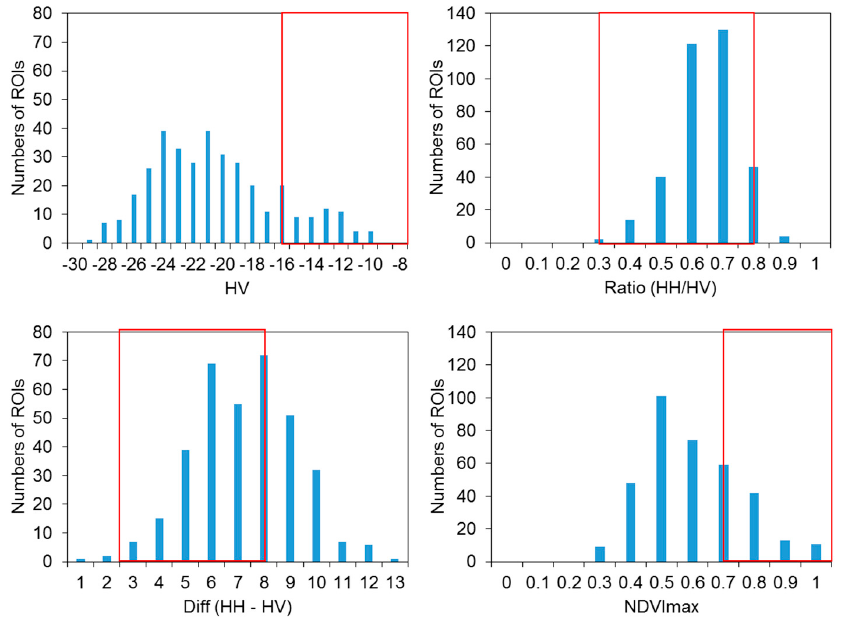
Figure 12. The distribution characteristics of shrub samples, collected by Oklahoma Biological Survey, the University of Oklahoma, in HV, Ratio (HH/HV), Difference (HH-HV) and NDVImax in 2010.